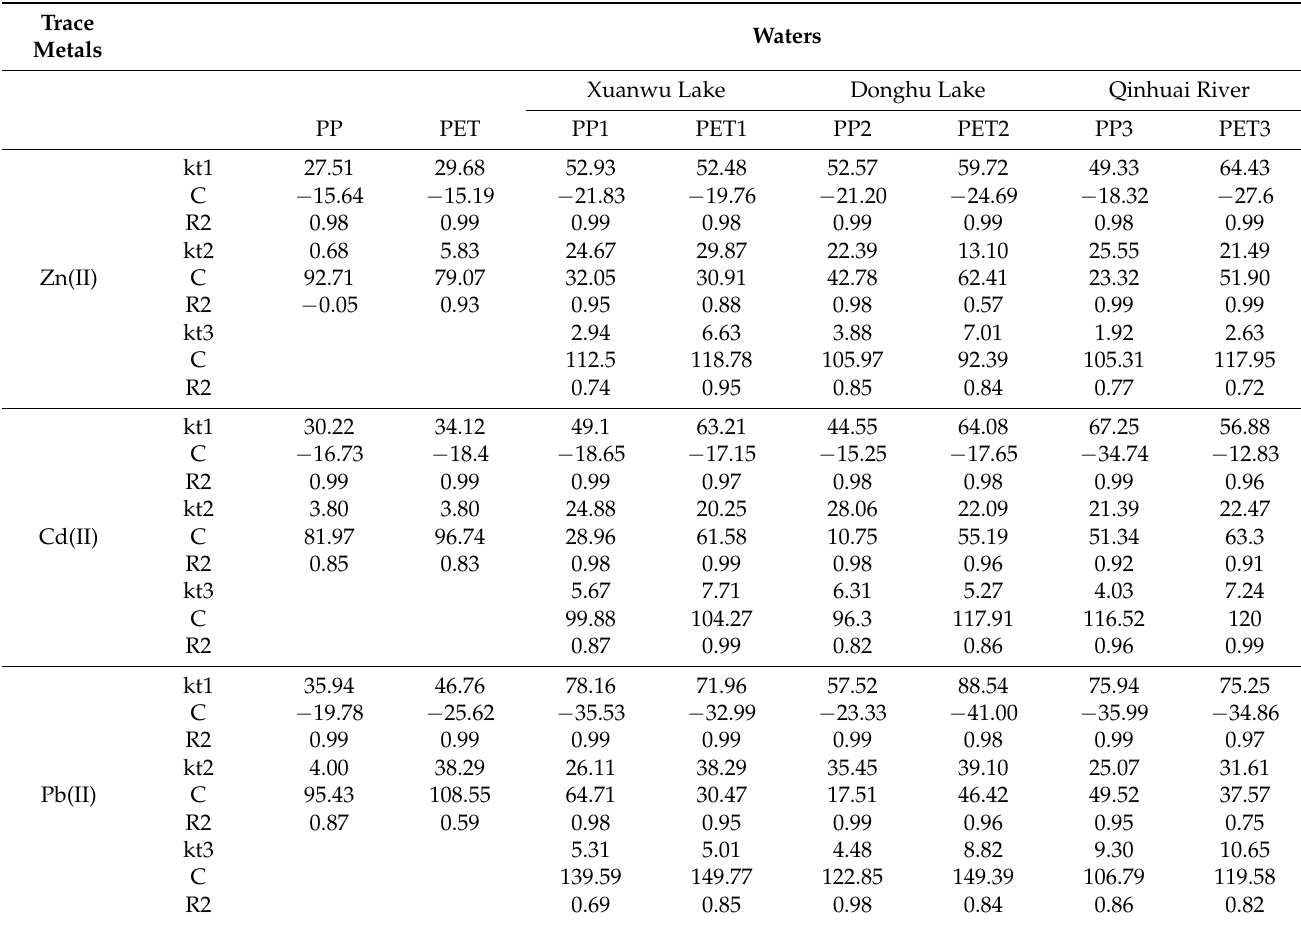
Table 3. Parameters of intraparticle diffusion model used in the